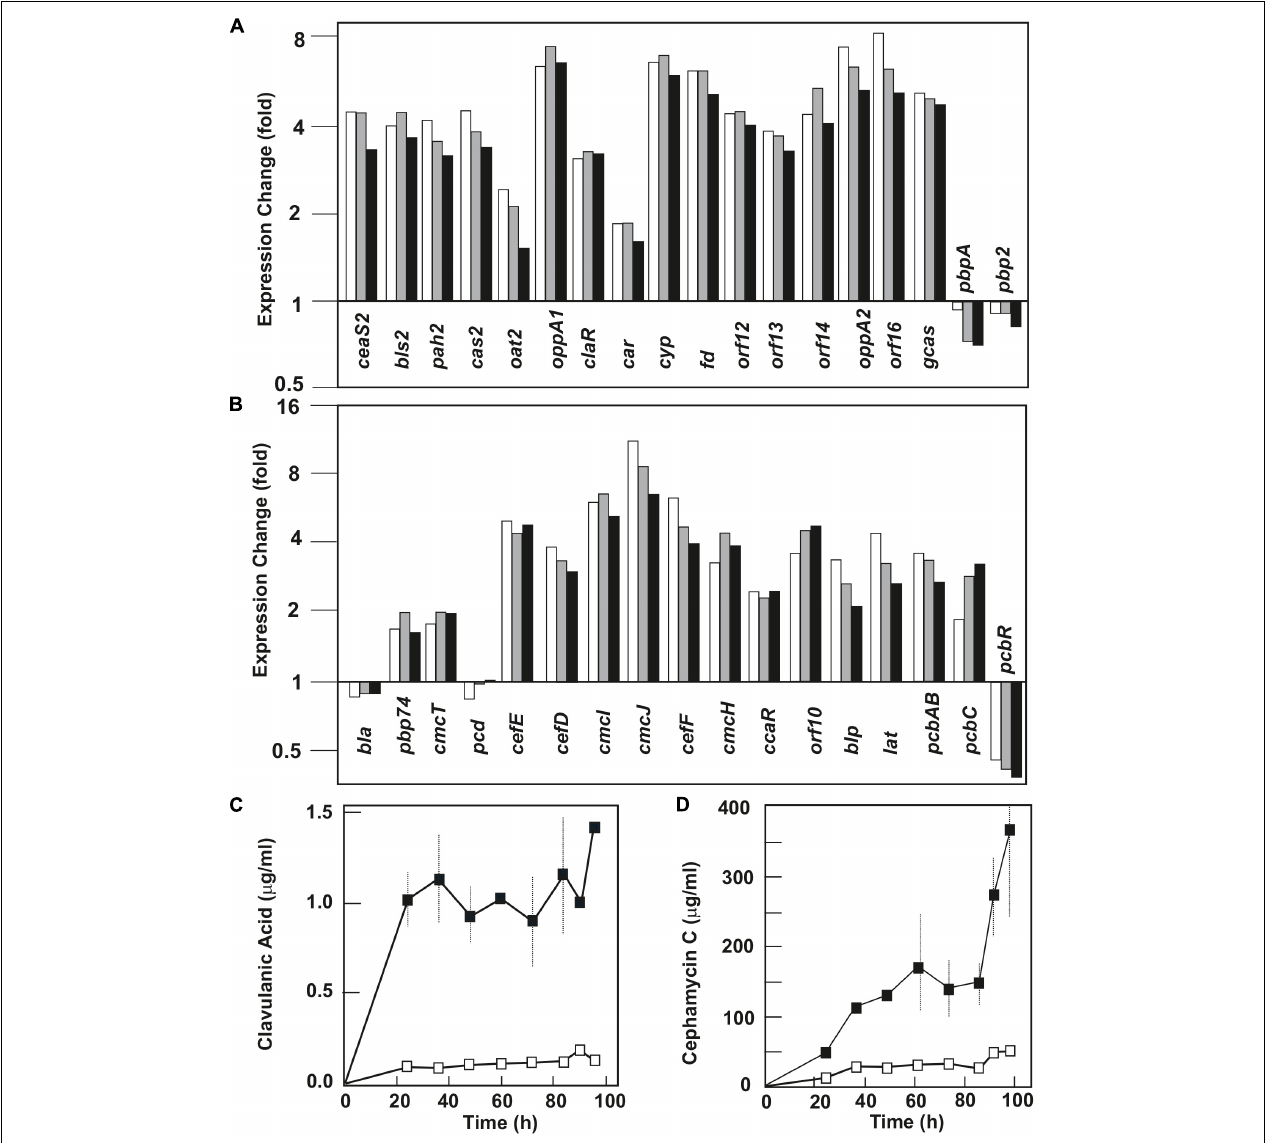
FIGURE 1 | Effect of PimM on the transcription level of the clavulanic acid and cephamycin C gene clusters and on the production of these two metabolites. Change in the expression level of genes for clavulanic acid (A) and cephamycin C (B) biosynthesis in Streptomyces clavuligerus :: pimM . The columns represent the average of the expression fold-change at 84 h (white columns), 90 h (gray columns), and 96 h (black columns). Gene names are indicated at the bottom of the columns. Expression level values of S. clavuligerus :: pimM are compared to those of the control strain, S. clavuligerus ::pIB139, normalized as 1. Clavulanic acid (C) and cephamycin C (D) production in MEY medium in S. clavuligerus :: pimM (black squares) and S. clavuligerus ::pIB139 (white squares). Vertical lines indicate standard deviations from three biological